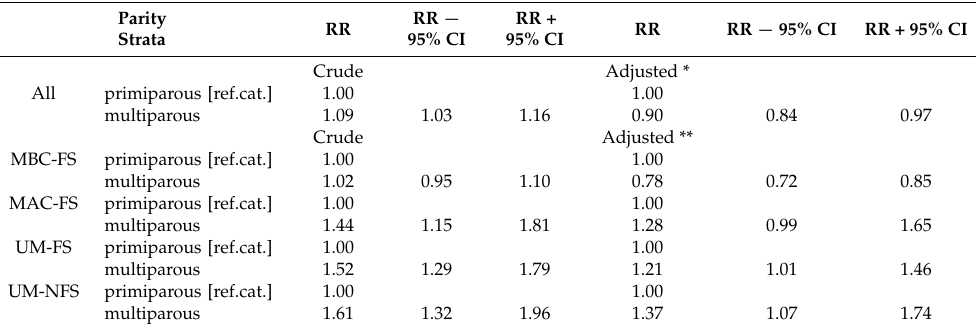
Table A1. The association between parity and preterm birth before and after stratification for Marital-Father Data index, tested by simple and multiple Poisson regression analyses. Crude and adjusted risk ratios (RR) with 95% confidence intervals (CI) of PTB by groups of Marital-Father Data